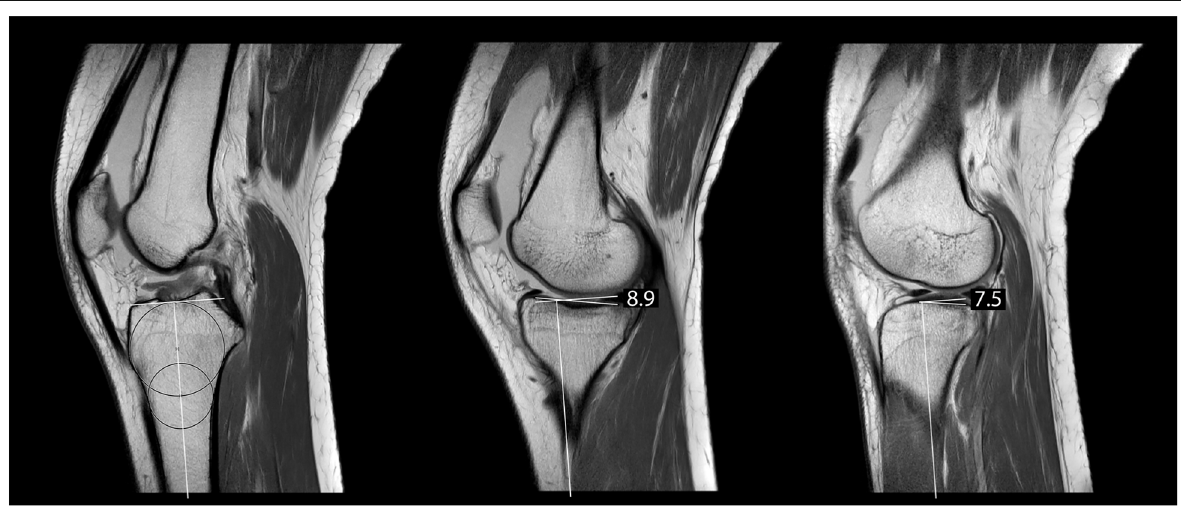
Fig. 2 Determination of the medial and lateral PTPA using MRI and the circle method [12, 20]. First, the central sagittal MRI image was found (left image). This image was determined using the following criteria: the anterior and posterior proximal tibia cortices were visible in concave shape and the intercondylar eminence and the posterior cruciate ligament attachment were visible in the image. In this image, a circle was fitted to the proximal tibia, tangential to the cortices. A second circle was fitted distally in the tibia with its centre placed on the first circle. The longitudinal axis was determined by the line connecting the centres of the two circles. Then, the mid-sagittal images of the medial and lateral femoral condyles were selected (middle and right image). The angle between the line connecting the anterior and posterior articular surface of the posterior tibia plateau and the line at right angles to the longitudinal axis of the tibia on both medial and lateral images were the MPTPA and LPTPA respectively